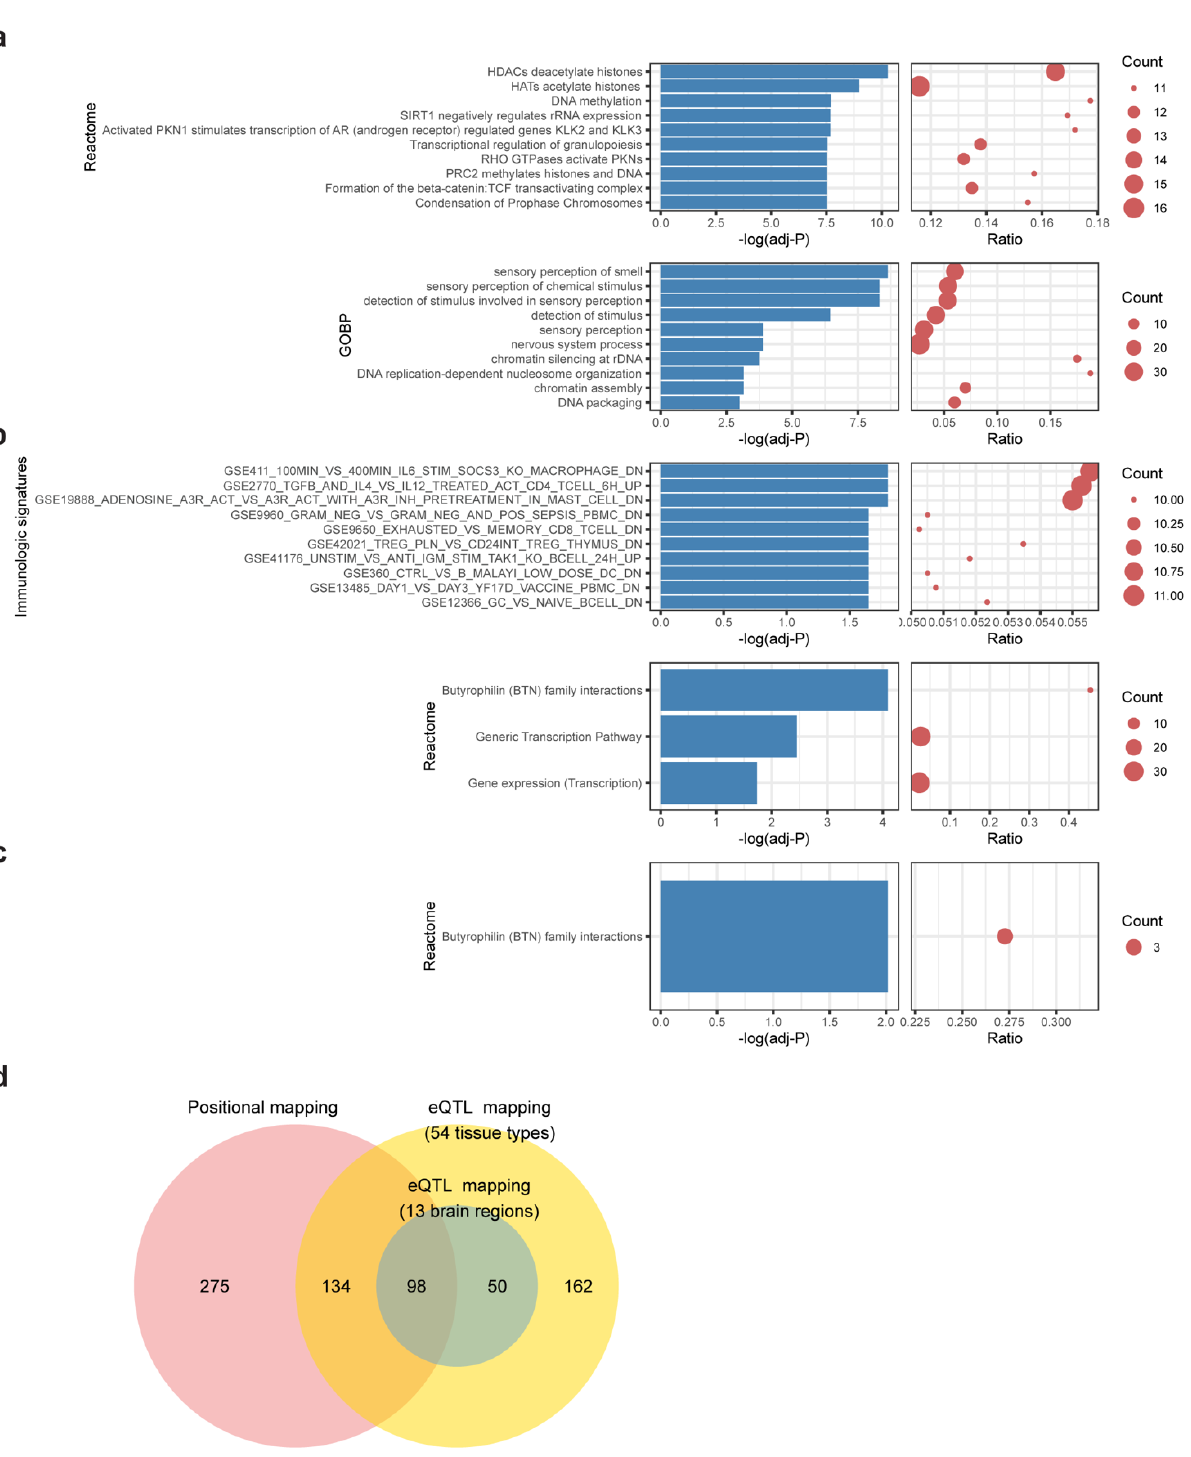
Figure 3. Functional enrichment of shared genes. Bar-dot plots show ( a ) top 10 significant enriched reactome gene sets and top 10 enriched GO biological processes (GOBP) of positional mapping genes; ( b ) enriched reactome gene sets and top 10 enriched immunologic signatures of eQTL mapping genes (54 tissues); ( c ) enriched reactome gene sets of eQTL mapping genes (brain regions). The p -value of ( a – c ) was FDR-adjusted, and enrichment cutoff was set at adjusted, p < 0.05. Count denotes number of genes hit in the respective gene set. Ratio represents the proportion of hit genes to the genes in gene set. ( d ) A Venn diagram showing the relationships of mapped genes under different mapping strategies.